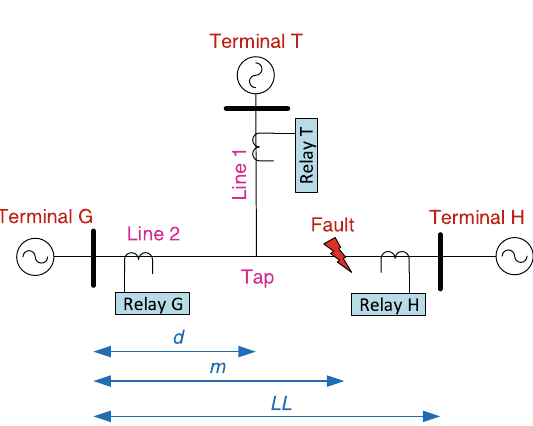
Fig. 1 Three-terminal transmission line model used for analysis